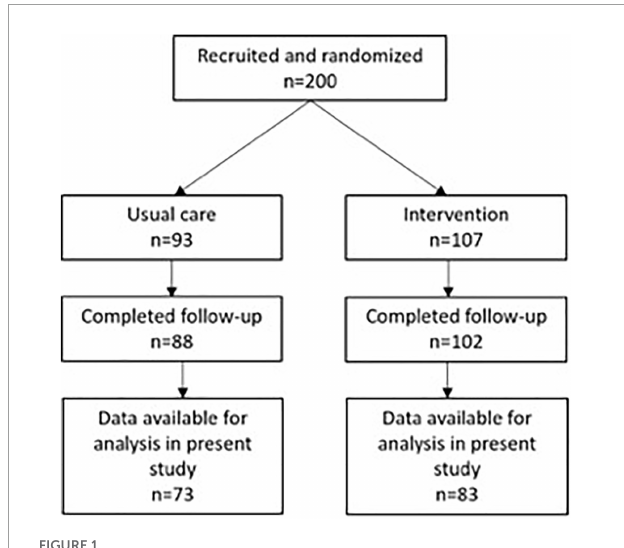
FIGURE1 Flow-chart for participants. Data available for analysis in present study refers to availability of serum neurofilament light at both baseline and follow-up.